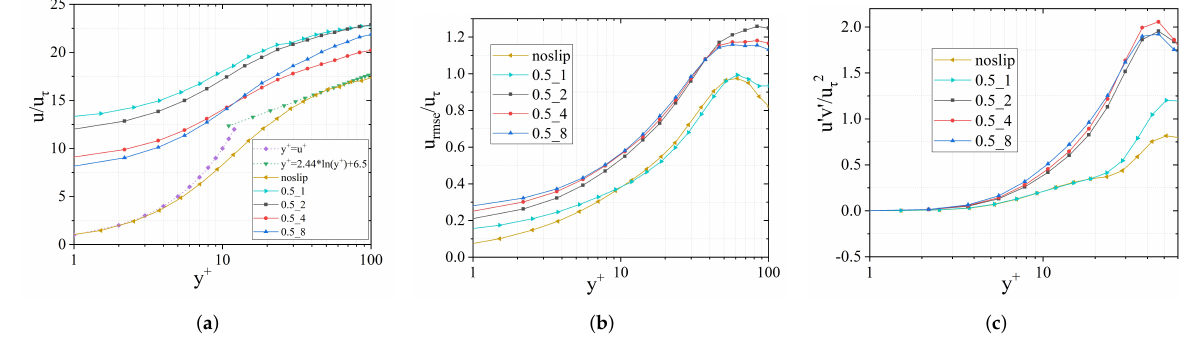
Figure 13. Comparison of statistics for GF = 0.5 and Strip number = 1,2,4,8 at the bottom wall of channel (superhydropho- bic surface). ( a ) Mean streamwise velocity profile. ( b ) Velocity RMSE fluctuations. ( c ) Reynolds stress.